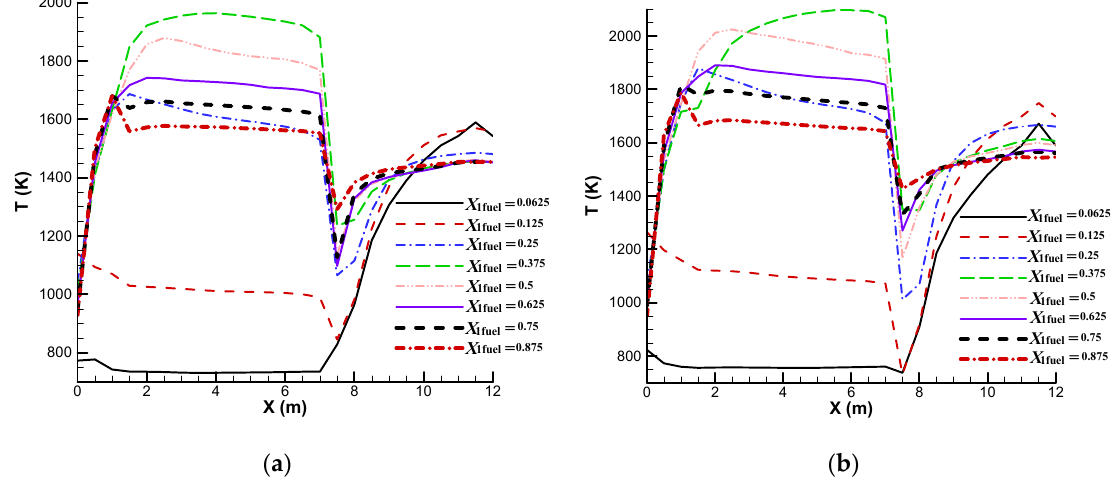
Figure 5. A comparison of the cross ‐ sectional average temperature for a SRU thermal reactor with different zone 1 fuel mass fractions: ( a ) Oxygen ‐ normal operation; ( b ) Oxygen ‐ rich operation.